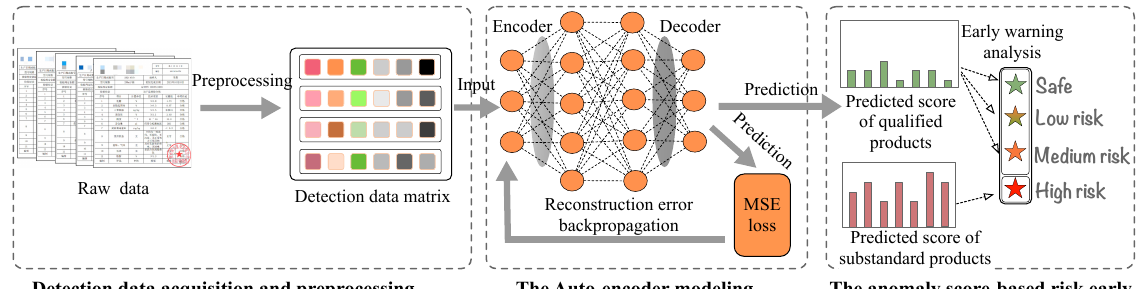
Figure 2. Overall architecture of ASRWS.